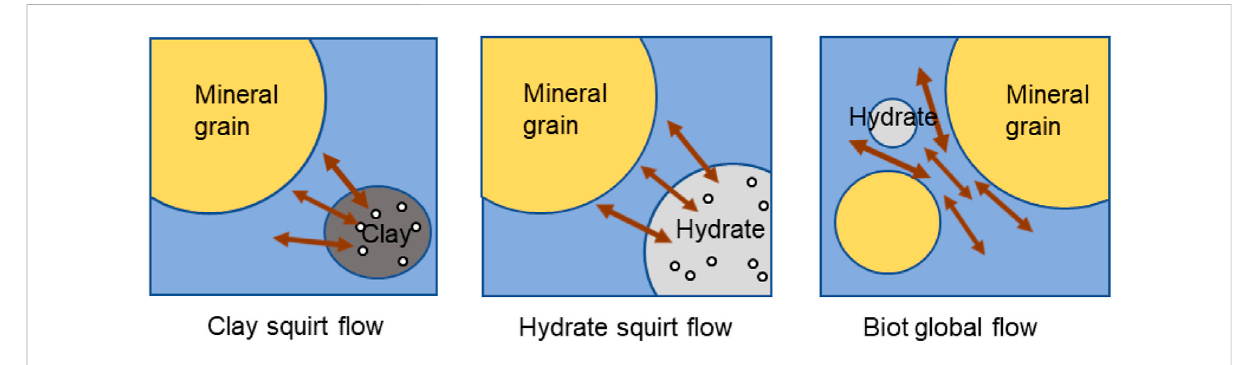
Attenuation mechanisms of the triple-porosity